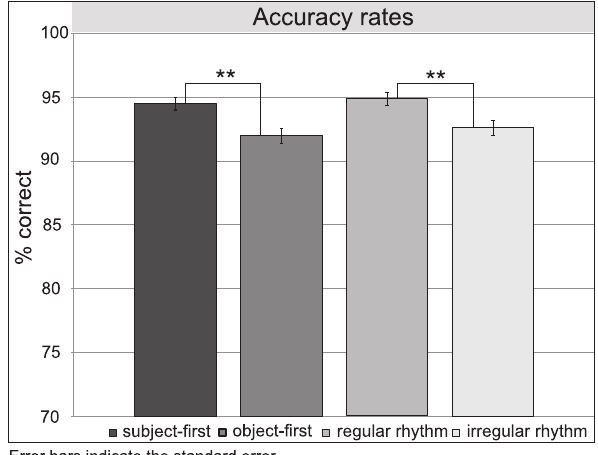
Figure 3. Accuracy rates for argumentposition and rhythm in the comprehension